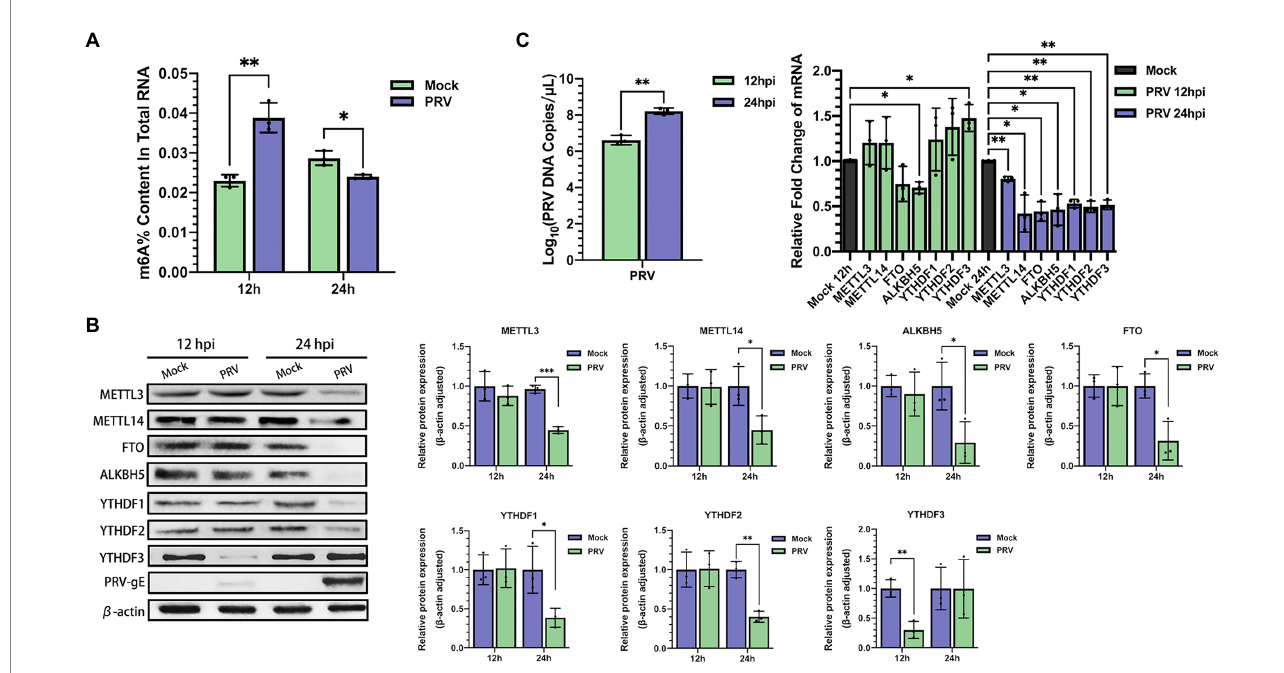
FIGURE 2 PRV infection affected m 6 A level and expression of m 6 A regulators in PK15 cells. (A) Total RNA was extracted from PRV-infected and uninfected PK15 cells at different time periods, and the m 6 A level of RNA was quantified by ELISA. (B) PK15 cells were infected with PRV for 12 and 24 h. m 6 A regulators were assessed by immunoblotting analysis. β -actin was used as a loading control. (C) RT-qPCR analysis was used to evaluate the mRNA levels of m 6 A regulators at different times of PRV infection. * p < 0.05, ** p < 0.01, *** p <